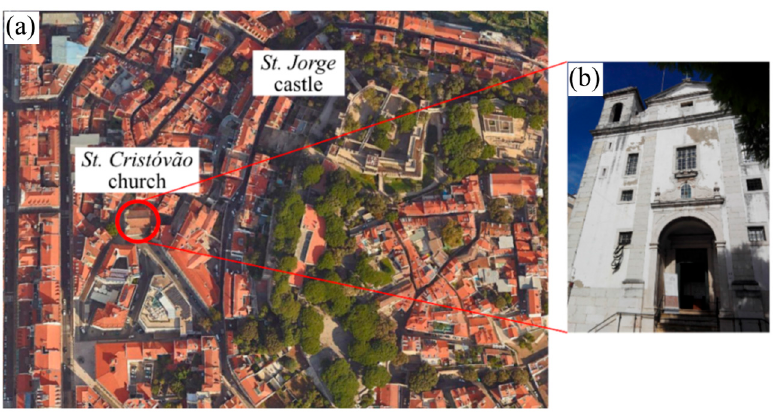
Figure 1. Location ( a ) and façade ( b ) of St. Cristóvão Church, Lisbon.